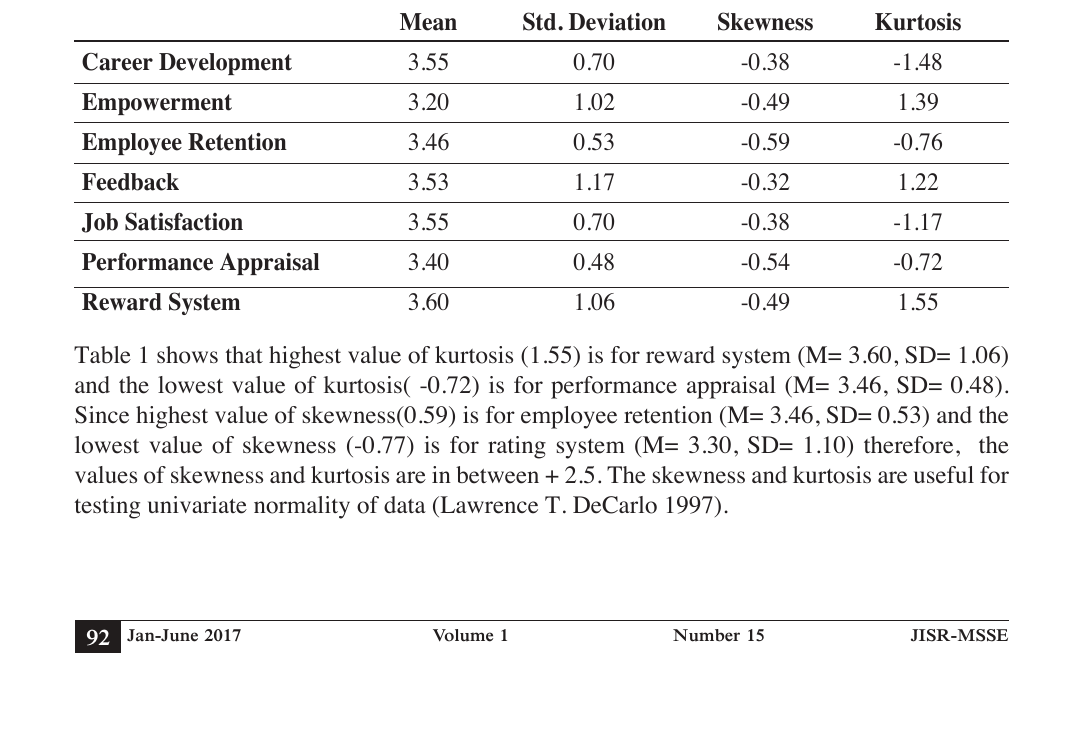
Table 1: Descriptive